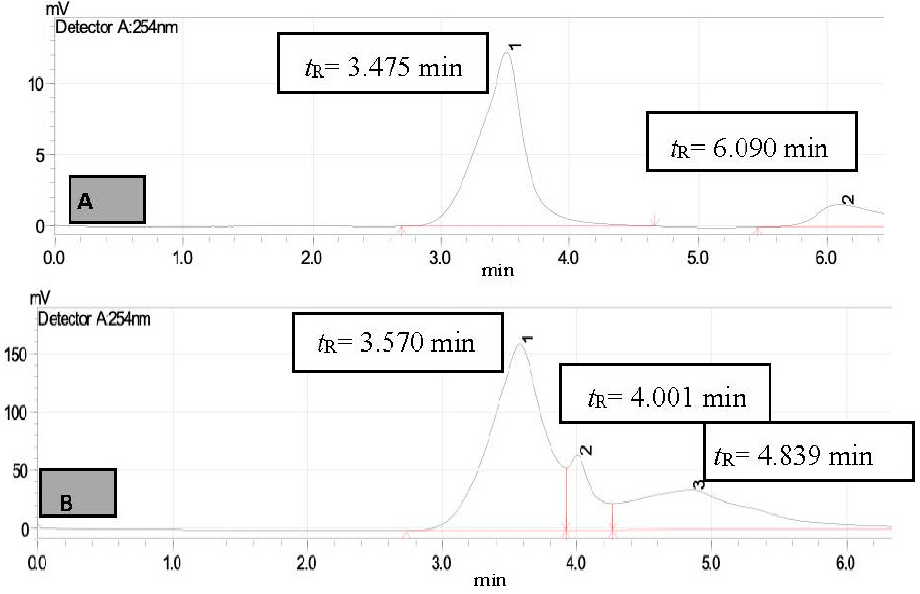
Figure 8. HPLC chromatogram of MTIE ( A )—untreated sample ( B )—treated sample, peak 1 for N-methylaniline ( t R = 3.570 min) and peak 2 ( t R = 4.001 min) and 3 ( t R = 4.839 min) for unknown compound.